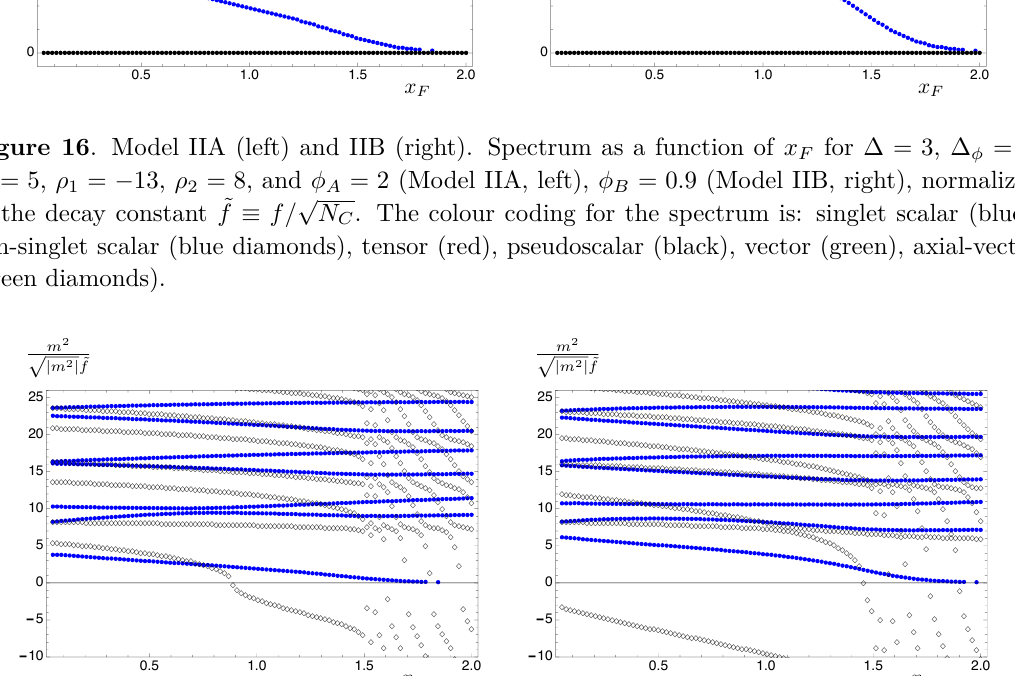
for ∆ = 3 , ∆ = 1 , g = 5 , ρ = − 13 , F φ 5 1